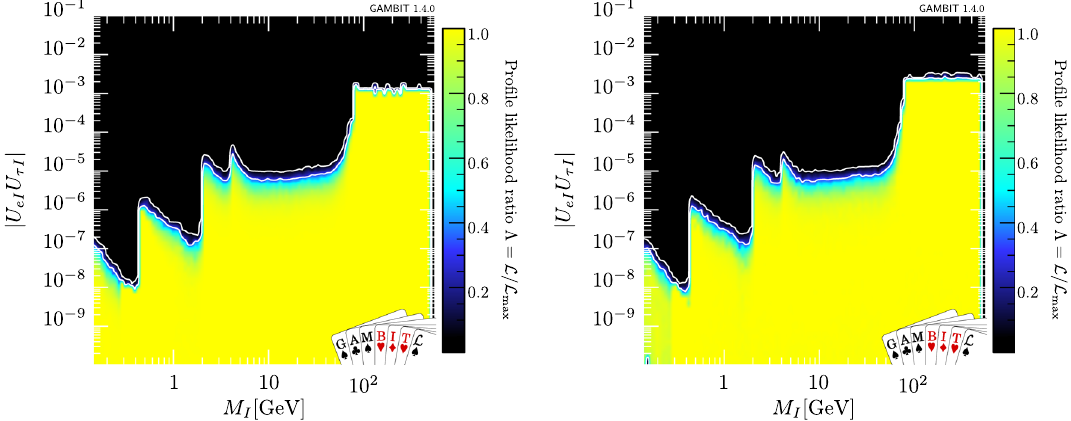
Fig. 6 Profile likelihood in M I vs | U eI U τ I | plane for normal (left) and inverted hierarchy (right). Tables with the 90% and 95% CLs for both hierarchies can be found in Zenodo [186]